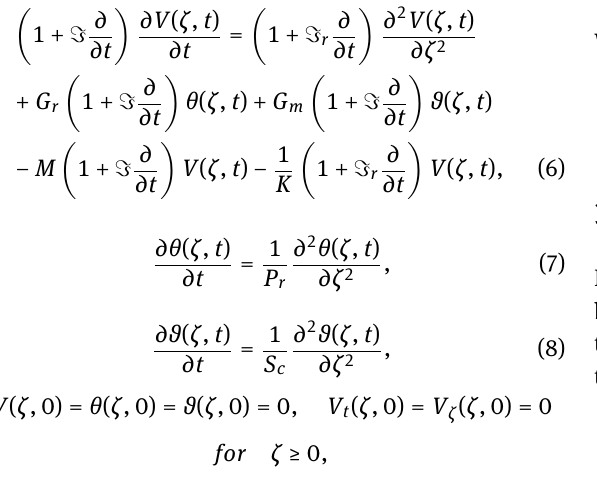
Applying (5) into (1) – (4), we get the set of dimension- less governing equations with corresponding